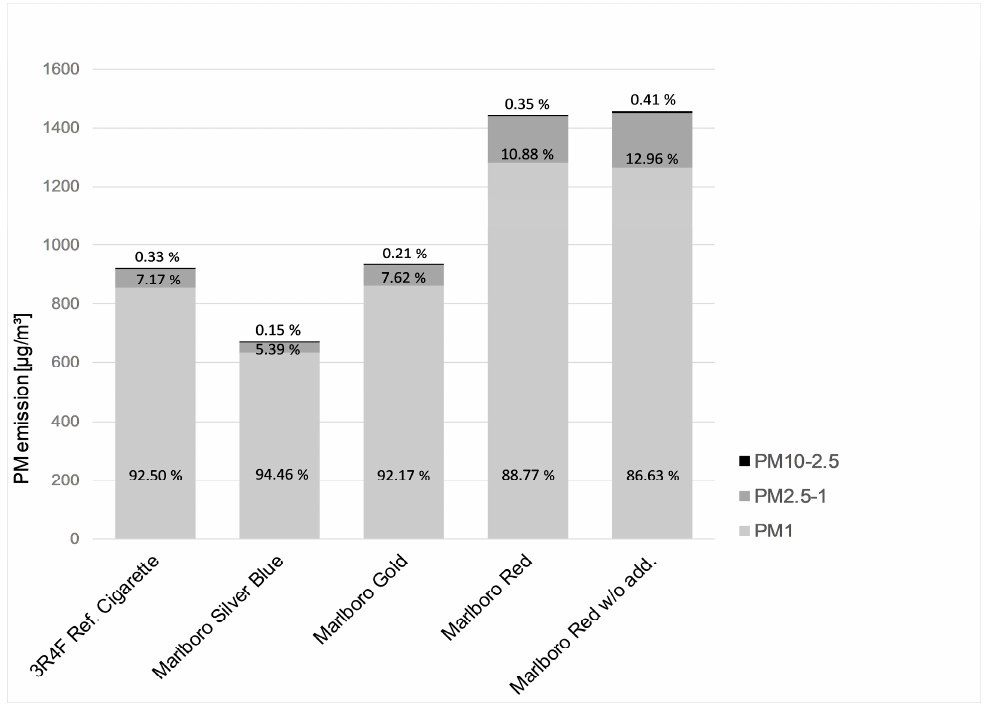
Figure 2. Distribution pattern of PM 10–2.5 , PM 2.5–1 , and PM 1 of all investigated cigarettes.